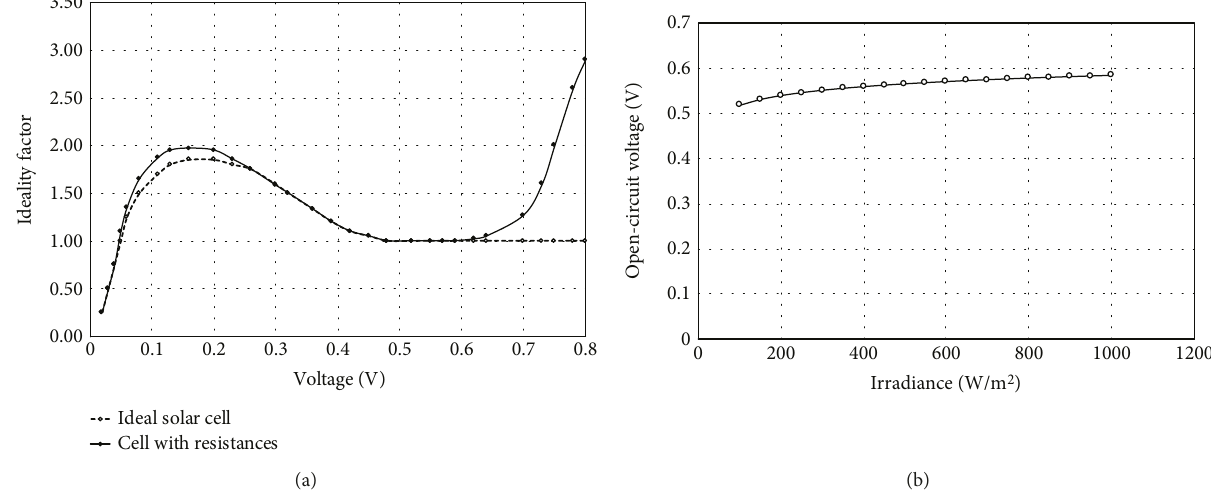
Figure 5: (a) Dependence of ideality factor on voltage across the junction. At low voltages, R high voltages, R dominates. (b) E ff ect of irradiance on voltage across the cell. The measurements in this document are con fi ned to between s 169W/m 2 and 1000W/m 2 as governed by the physical setup of the